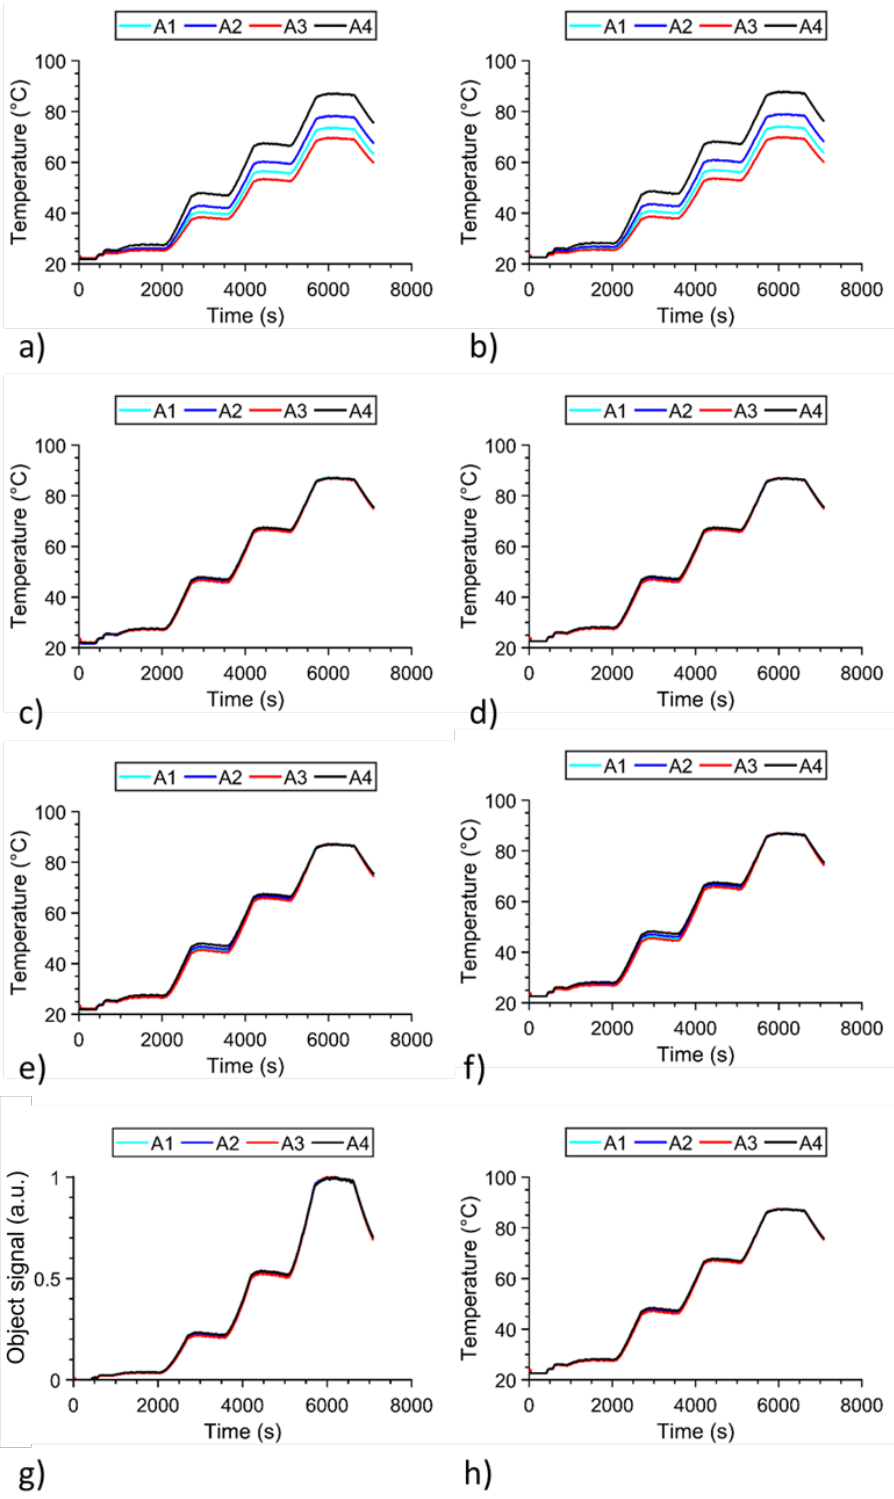
Figure 8. Measurement result for FLIR A6751 (MWIR): ( a ) raw data (whole image emissivity 0.92), ( b ) raw data − 1st image + Tinit (emissivity 0.92), ( c ) emissivity correction method 1 of ( a ), ( d ) emissivity correction method 1 of ( b ), ( e ) emissivity correction method 2 of ( a ), ( f ) emissivity correction method 2 of ( b ), ( g ) emissivity correction method 3 in OS, ( h ) emissivity correction method 3 in °C.